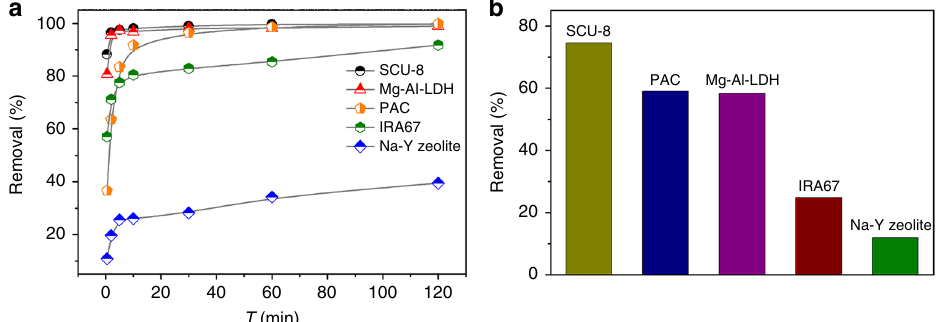
Fig. 4 The results of PFOS sorption kinetics and selectivity by various materials. a A comparison of PFOS sorption kinetics by SCU-8, Mg-Al-LDHs, IRA67, PAC, and Na-Y zeolite, with the same solid-to-liquid ratio of 0.2 mmol/40 ml and the initial PFOS concentration of 1 mg l − 1 . b A comparison of PFOS removal percentages at the equilibrium state in the presence of large excess of multiple competing anions Cl − , NO 3 − , SO 4 2 − , and CO 3 2 − by SCU-8, Mg-Al- LDHs, IRA67, PAC, and Na-Y zeolite. The concentration of each competing anion is 50 mg l − 1 and the initial PFOS concentration of 1 mg l − − SCU-8 is able to effectively remove ReO 4 with a fast kinetics. Approximately 80% of the ReO 4 − anions were removed within 2 min and the sorption equilibrium was reached in less than 10 min (Fig. 3d). The sorption isotherms of ReO 4 − are shown in Fig. 3e and were fi t using the Langmuir mode (Supplementary Table 3).